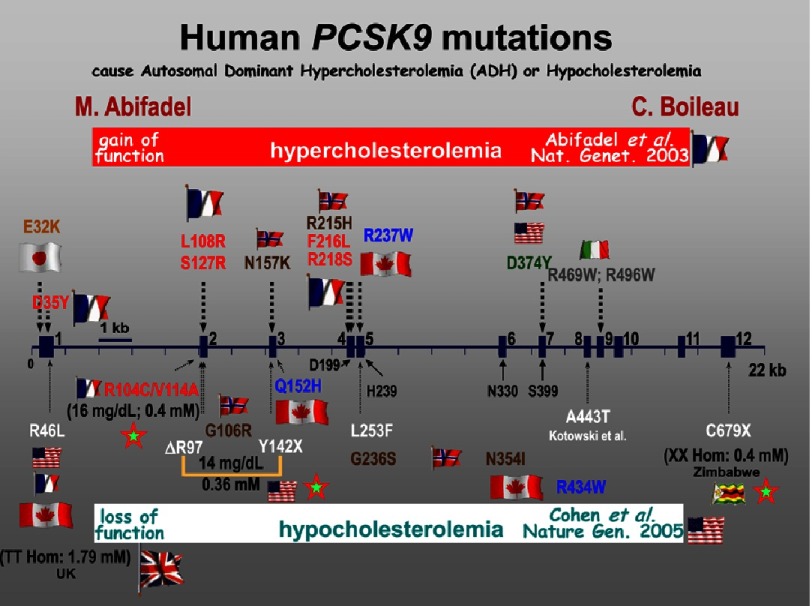
Schematic representation of the exon/intron structure of the PCSK9 gene and the identified GOF and LOF mutations.The first reports of GOF (above the gene) and LOF (below the gene) PCSK9 mutations are emphasized, as well as the countries of origin of each reported mutation. Notice that the 3 complete LOF mutations of PCSK9 are denoted with green stars with a red border, and the 0.4 mM levels of LDLc reached.